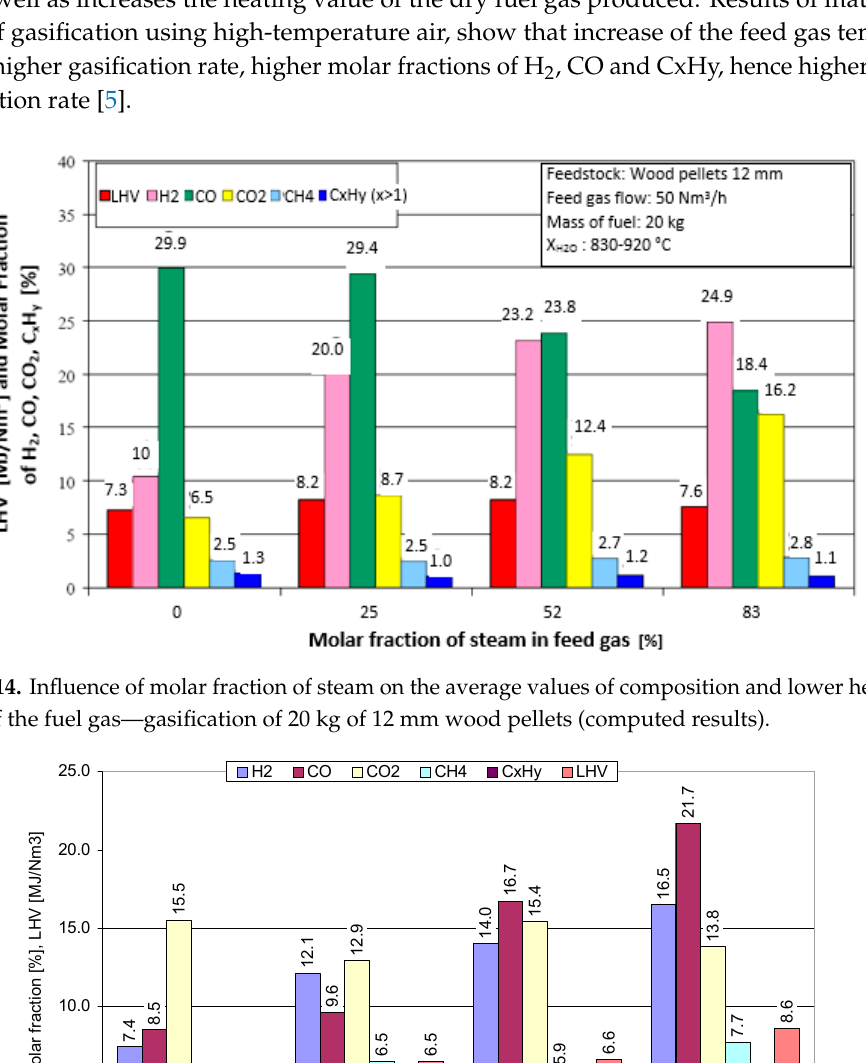
Figure 14. Influence of molar fraction of steam on the average values of composition and lower heating value of the fuel gas—gasification of 20 kg of 12 mm wood pellets (computed results).